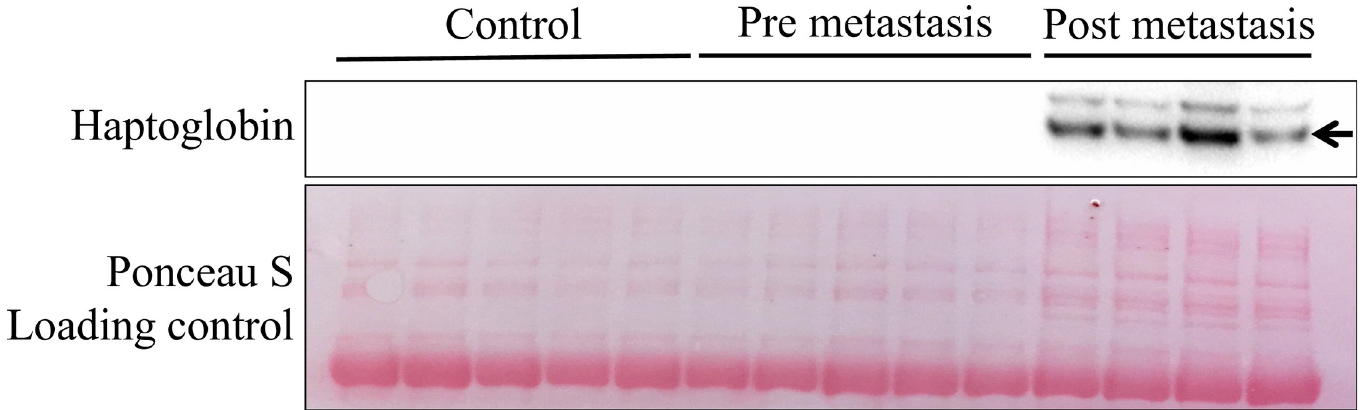
Fig 7. Western blot of plasma confirms a major up-regulation of haptoglobin after metastasis. Ponceau S was used as a loading control for total protein.